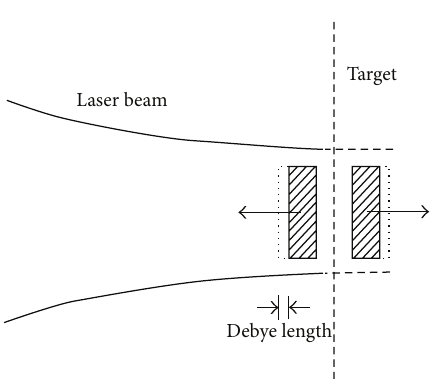
Figure 3: Scheme of skin depth laser interaction where the non- linear force accelerates a plasma block against the laser light and another block towards the target interior. In front of the blocks are electron clouds of the thickness of an effective Debye length of less than 500